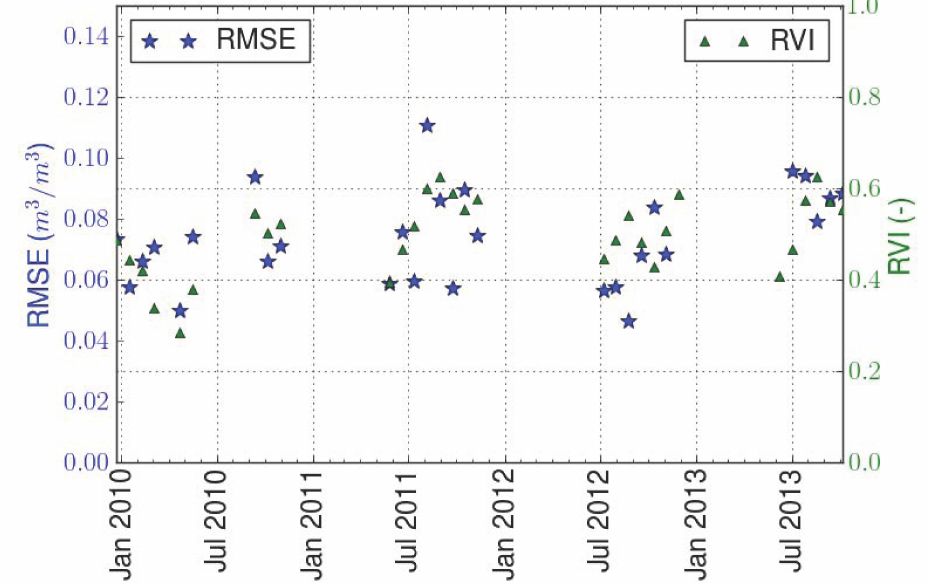
Figure 11. Temporal behaviour of mean RVI, and RMSE computed by comparing the retrieved SM from HH polarization by using the CT model for each